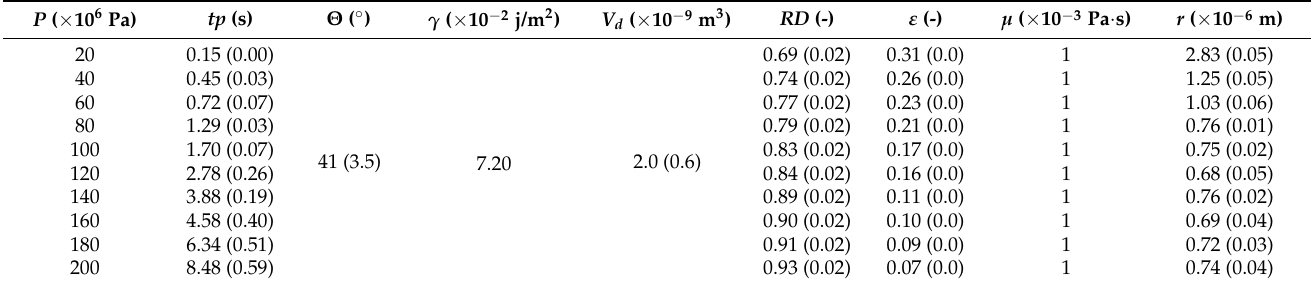
Figure 7. Series of images showing ( a ) the water droplet at the tip of the needle and the tablet surface, ( b ) the contact between the tablet surface and the droplet, ( c – d ) the penetration, and ( e ) the end of the penetration and the swelling of the particle after the penetration. The tablet was compressed at 200 MPa. Table 2 lists the mean penetration time measured for the compressed powder tablet produced with compression pressures ranging from 20 MPa to 200 MPa. The calculated average (Equation (8)) pore radius for each compression pressure is also shown. Table 2. Measured water droplet penetration time and calculated pore radius values.